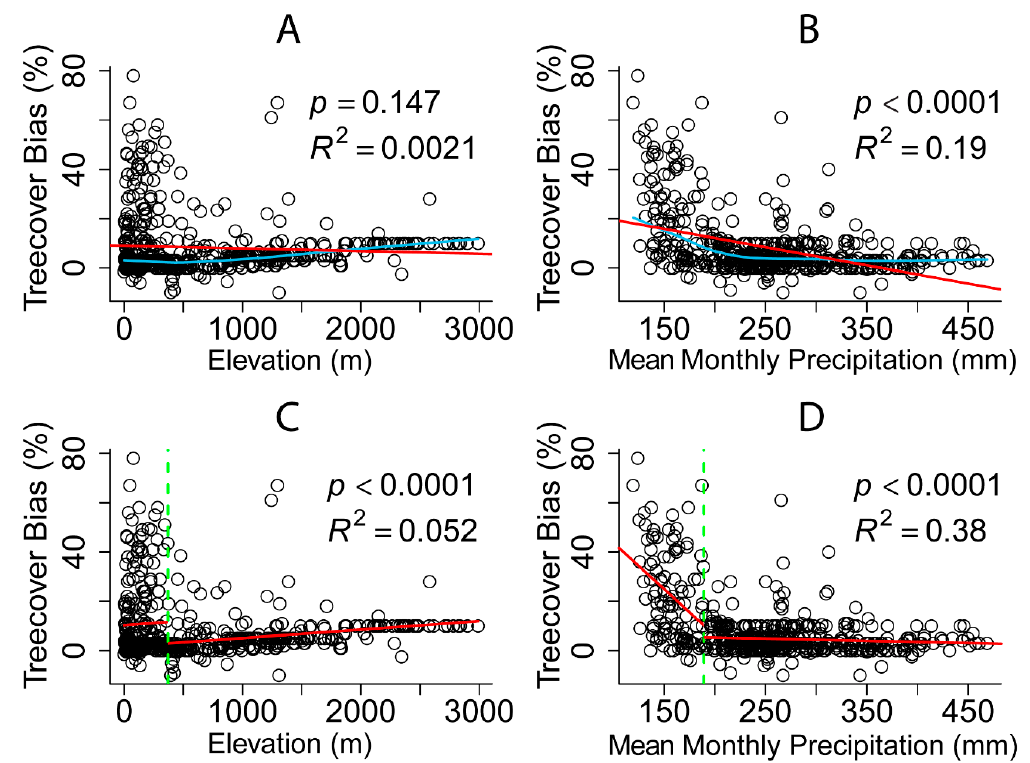
Figure 8. Regressions of calculated tree cover bias (reference tree cover—GFC tree cover) against elevation and precipitation, respectively. All data shown is classified as forest in the reference data (true tree cover >90%). In the first row of graphs, the red lines indicate linear model fits to the data, and the blue lines show LOESS regressions for illustration purposes. Subfigure ( A) shows the elevation linear fit, while subfigure ( B) shows the precipitation linear fit. The second row shows segmented linear regressions (red lines) fit to subsets of the data on either side of the changepoints (green dotted lines). Subfigure ( C ) shows the elevation segmented regression fit, while subfigure ( D) shows the precipitation segmented regression fit.